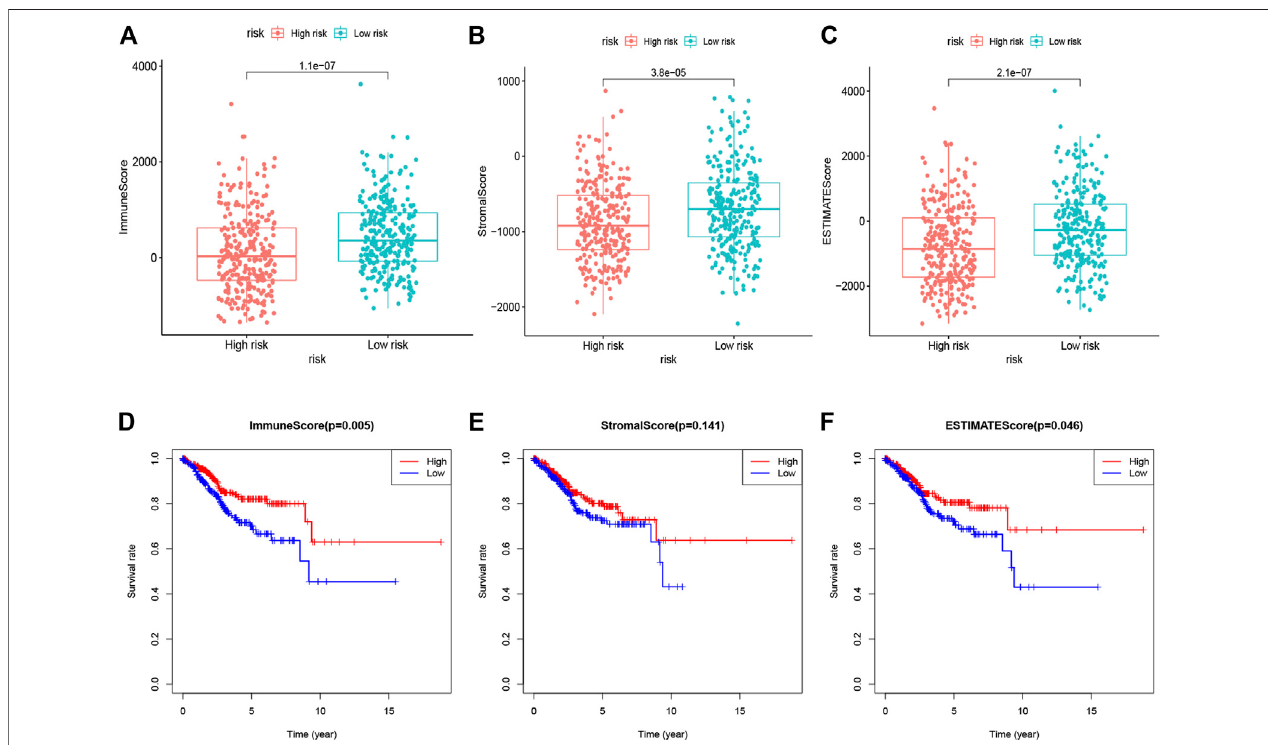
FIGURE 6 | Immune scores, stromal scores, and ESTIMATE scores of 10 glycolysis-related gene signatures were related to risk score (A) . Immune scores for patients in the low- vs. high-risk group (B) . The stromal scores for patients in the low- vs. high-risk group (C) . The ESTIMATE scores for patients in the low- vs. high-risk group (D) .Kaplan-Meieranalysisofoverallsurvivalforpatientswithlowvs.highimmunescores (E) .Kaplan-Meier analysisofoverallsurvivalforpatientswithlowvs.high stromal scores (F) . Kaplan-Meier analysis of overall survival for patients with low vs. high ESTIMATE scores.